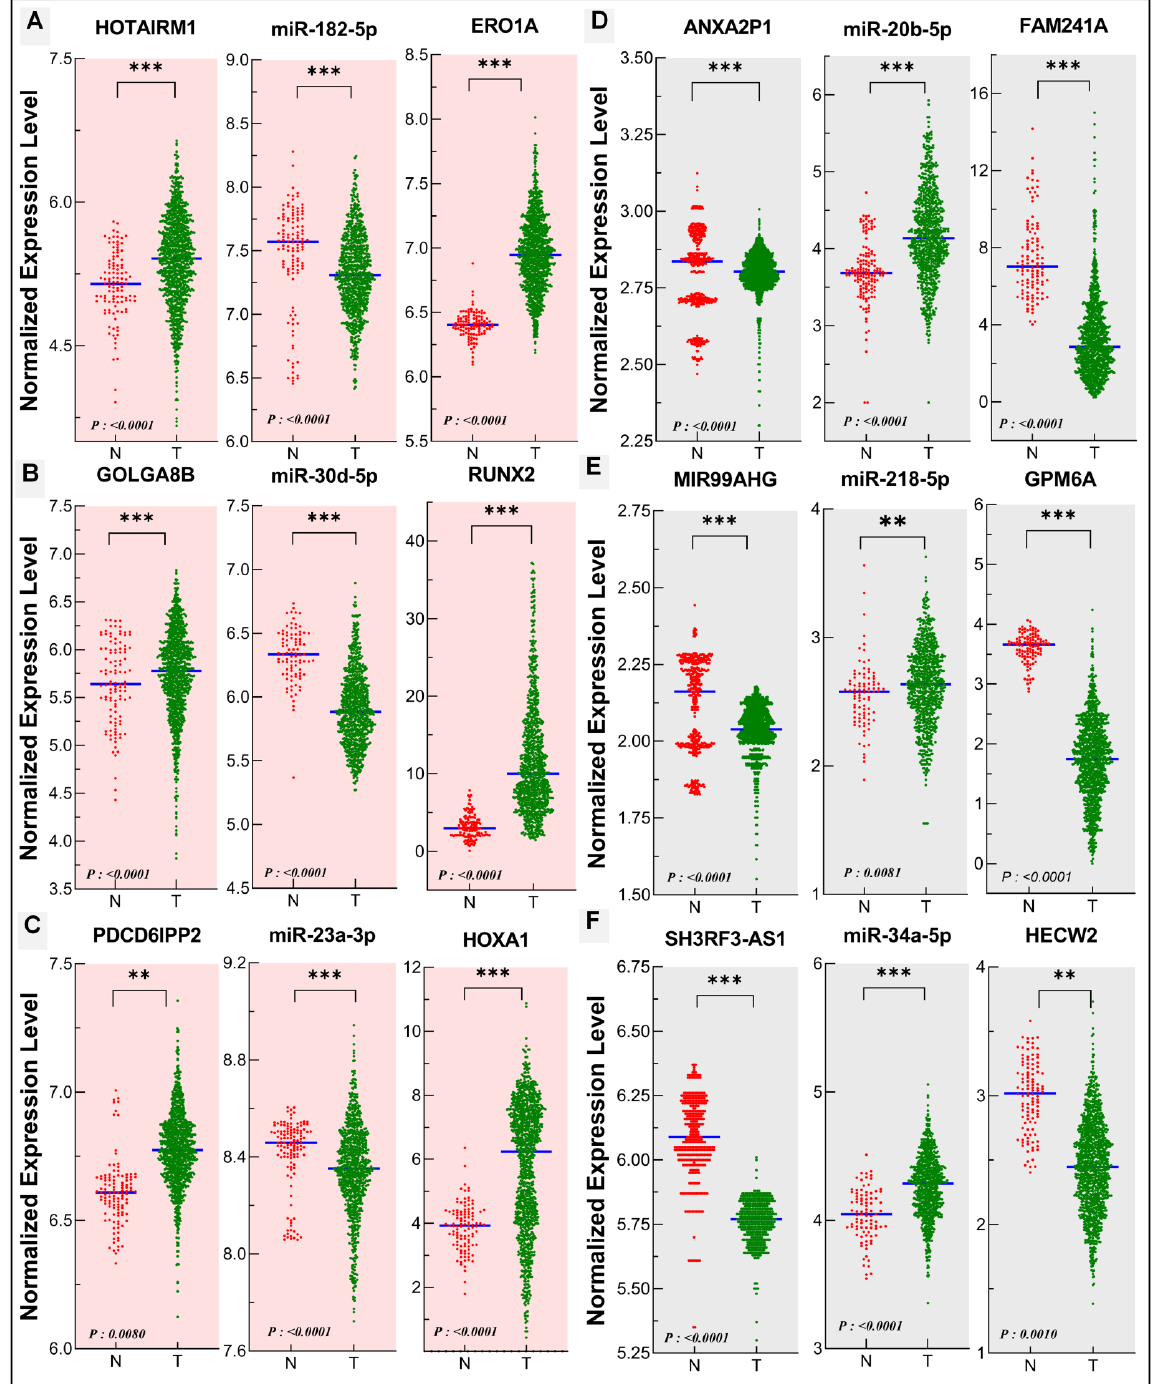
Figure 6. Validation of expression levels of lncRNAs, miRNAs, and mRNAs in identified oncogenic and tumor suppressive ceRNA modules in human lung cancer using gene expres- sion profiling interactive analysis. ( A – C ) The oncogenic axes HOTAIRM1/miR-182-5p/ERO1A, GOLGA8B/miR-30d-5p/RUNX2, and PDCD6IPP2/miR-23a-3p/HOXA1. ( D – F ) The tumor sup- pressor axes ANXA2P1/miR-20b-5p/FAM241A, MIR99AHG/miR-218-5p/GPM6A, and SH3RF3- AS1/miR-34a-5p/HECW2. N: normal tissue samples ( n = 110); T: tumor tissue samples ( n = 1050) (for tumor suppressive MIR99AHG, SH3RF3-AS1, and ANXA2P1 n = 450 and T = 2050). **, p ≤ 0.05; ***, p ≤